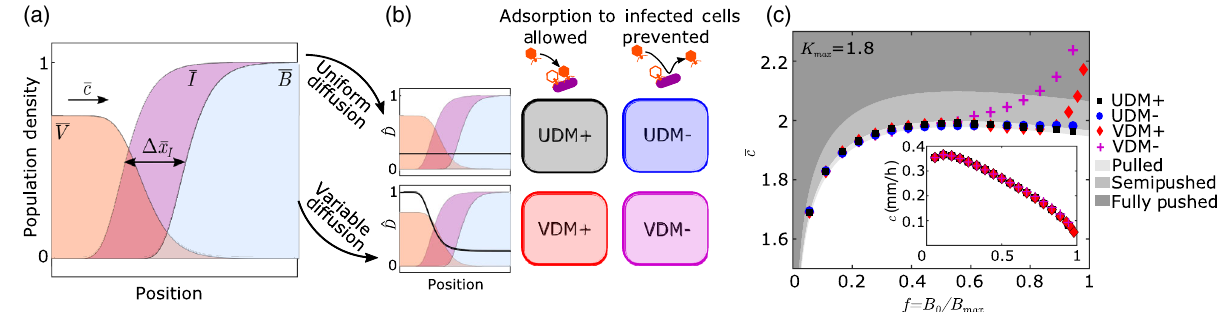
¯ B ¯ I; ¯ V FIG. 2. (a) A sketch of the population concentrations , and as a function of the location at the expansion front (the precise location is not important here, as the qualitative shape of the fronts remains constant during the expansion). The front is propagating with dimensionless velocity ¯ c to the right. The dimensionless width Δ ¯ x I characterizing the width of the infected region is given by the ¯ B ¯ B þ ¯ I difference in position of the uninfected ( ) and infected fronts ( ). (b) The differing diffusion and adsorption behaviors explored ˆ D ¼ D=D lead to four different model variants in this work. Variants either have a uniform or variable diffusion coefficient 0 [UDM or VDM, respectively, black line in (b)], and adsorption to previously infected cells either does ( þ ), or does not ( − ) occur, leading to the four model variants (UDM þ , UDM − , VDM þ , and VDM − ). (c) Dimensionless front velocity ¯ c as a function of the bacteria fraction f , with shaded regions indicating the different expansion types. Error bars on the velocities are smaller than the symbols. Inset also shows the dimensional velocity c . Model parameters are chosen to represent typical T7 expansions with β ¼ 50 , τ ¼ 18 min, and α B ¼ 0 . 1 min − 1 [21,32,35] corresponding to K ¼ 1 . 8 in our max max